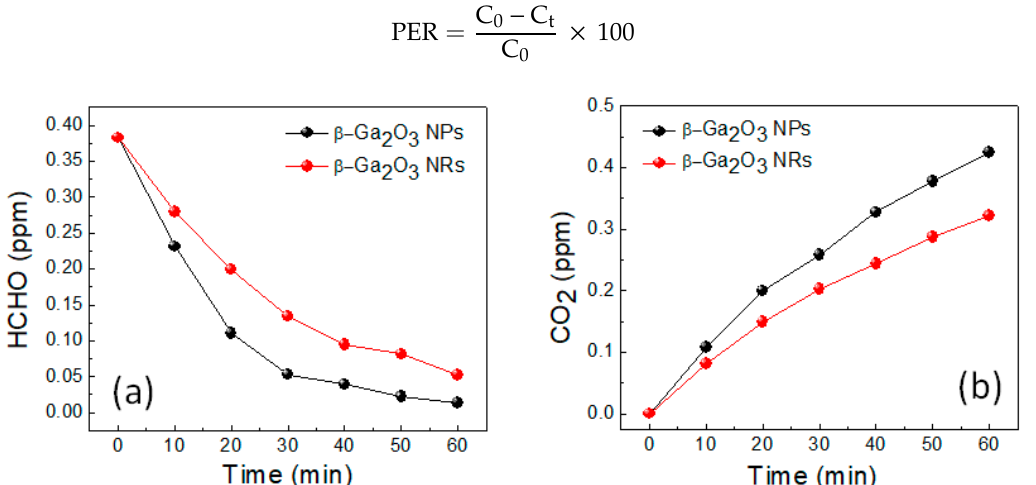
Figure 4. Photocatalytic activity of β -Ga 2 O 3 NRs and NPs for HCHO degradation under UVC irradiation: ( a ) concentration degradation of HCHO. ( b ) Amount of CO 2 product as a function of